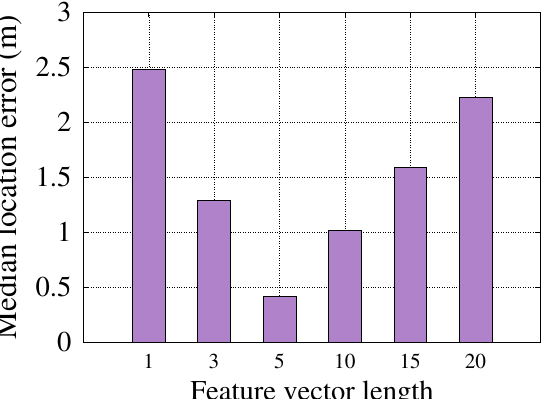
Figure 10. Effect of changing the feature vector length on RRLoc accuracy.